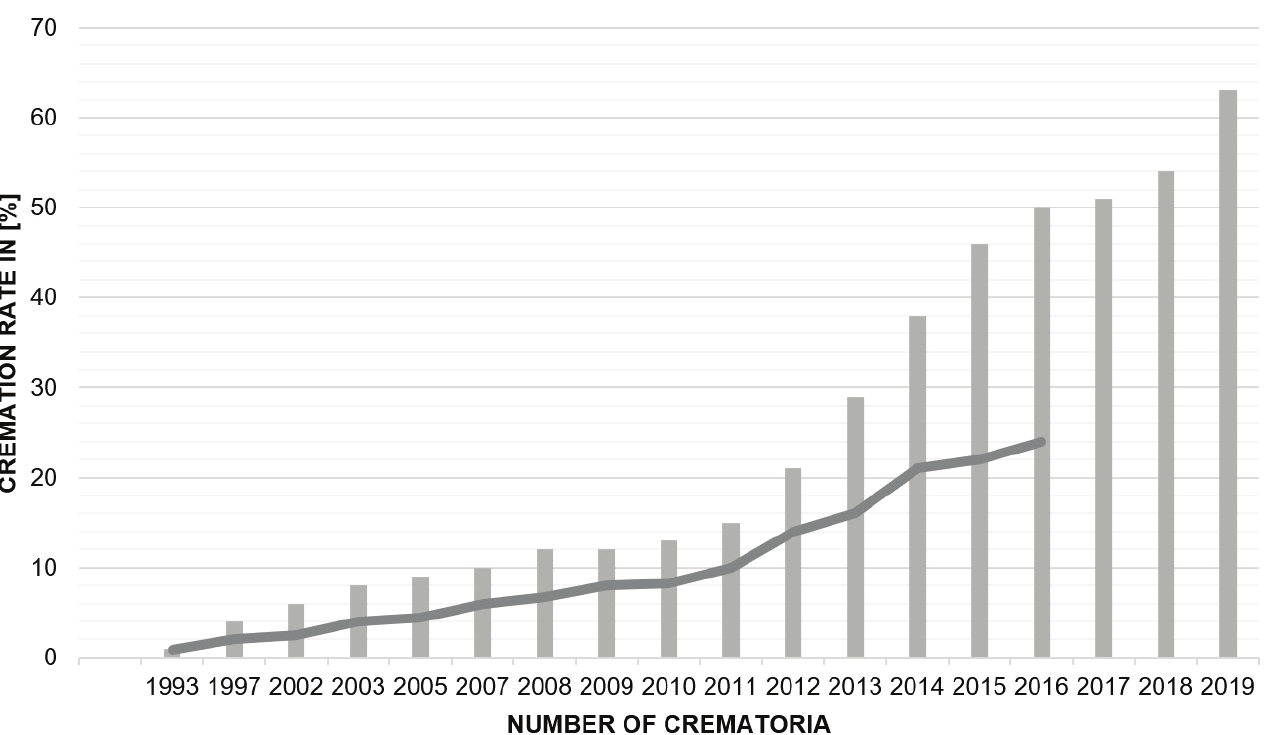
Figure 1. Number of crematoria and cremation rate* in Poland in 1993-2019. Own